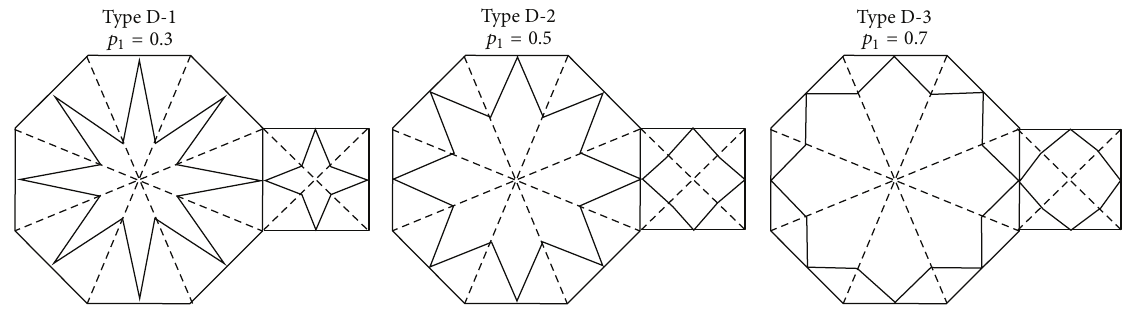
Figure 29: Examples of basic variations: Type D.